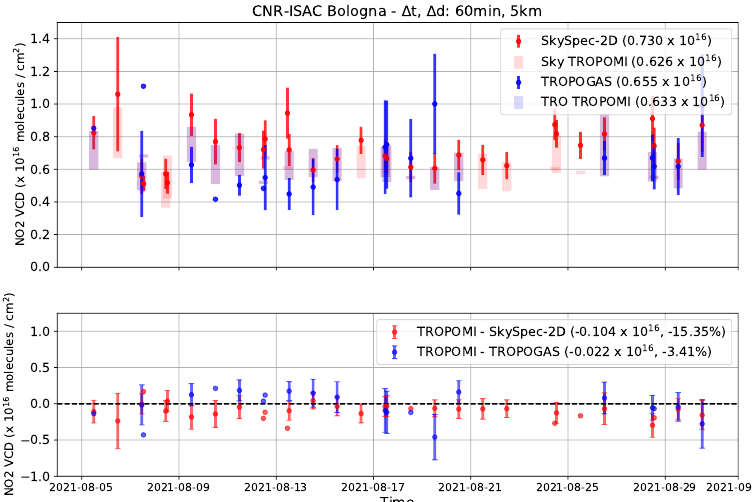
Figure 7. NO 2 VCDs, averaged in 60 min intervals around the satellite overpass, from TROPOGAS (in red) and SkySpec-2D (in blue) versus TROPOMI (red and blue shadows, respectively) during the Bologna inter-comparison campaign. The TROPOMI shadows represent the mean values within the 5 km radius with standard